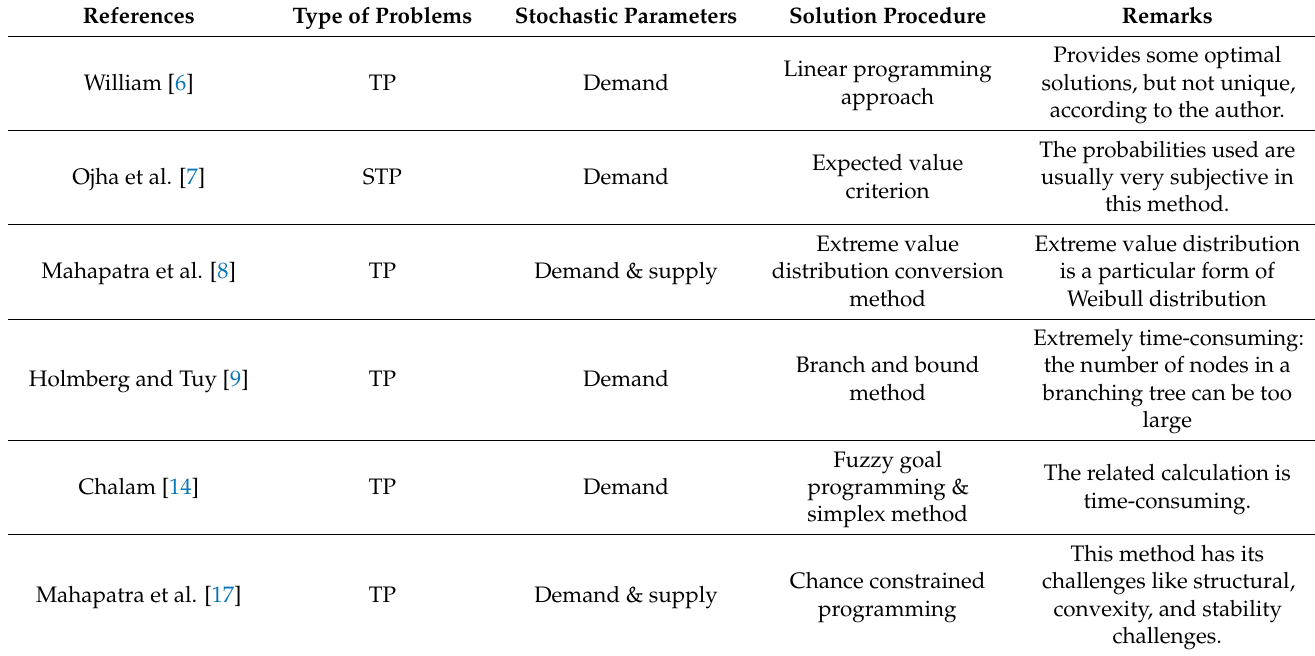
Table 1. A comparative analysis of the methodology with the existing